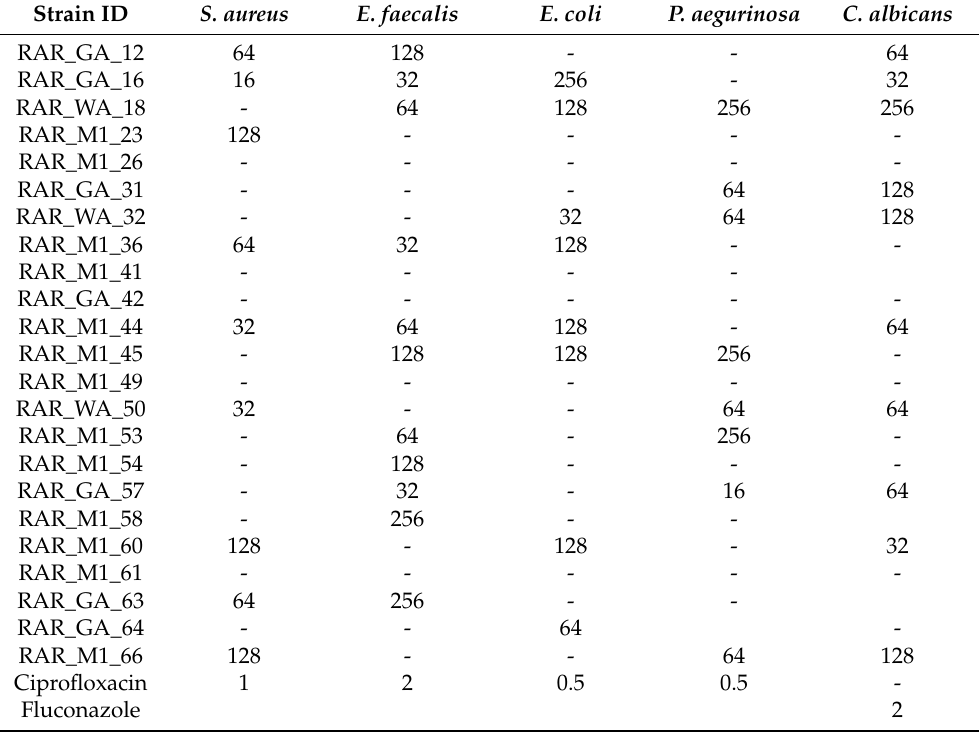
Table 2. Antimicrobial activity of the bacterial extracts (MIC, µ g/mL). Strain